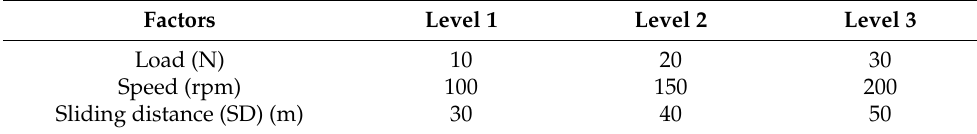
Table 1. Factors and levels for experimental work.